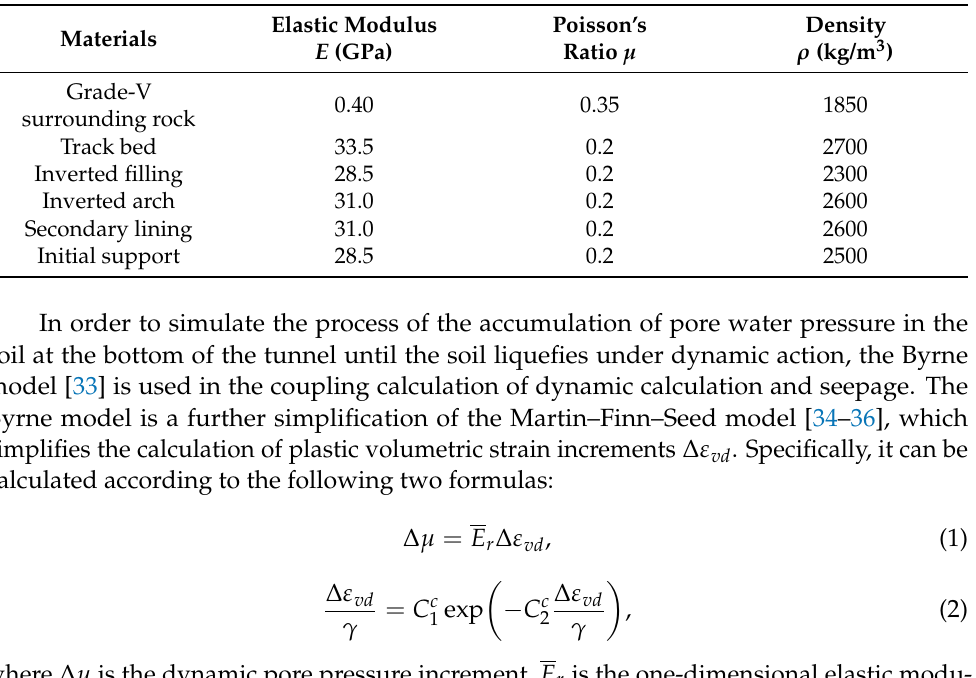
Table 1. Physical and mechanical